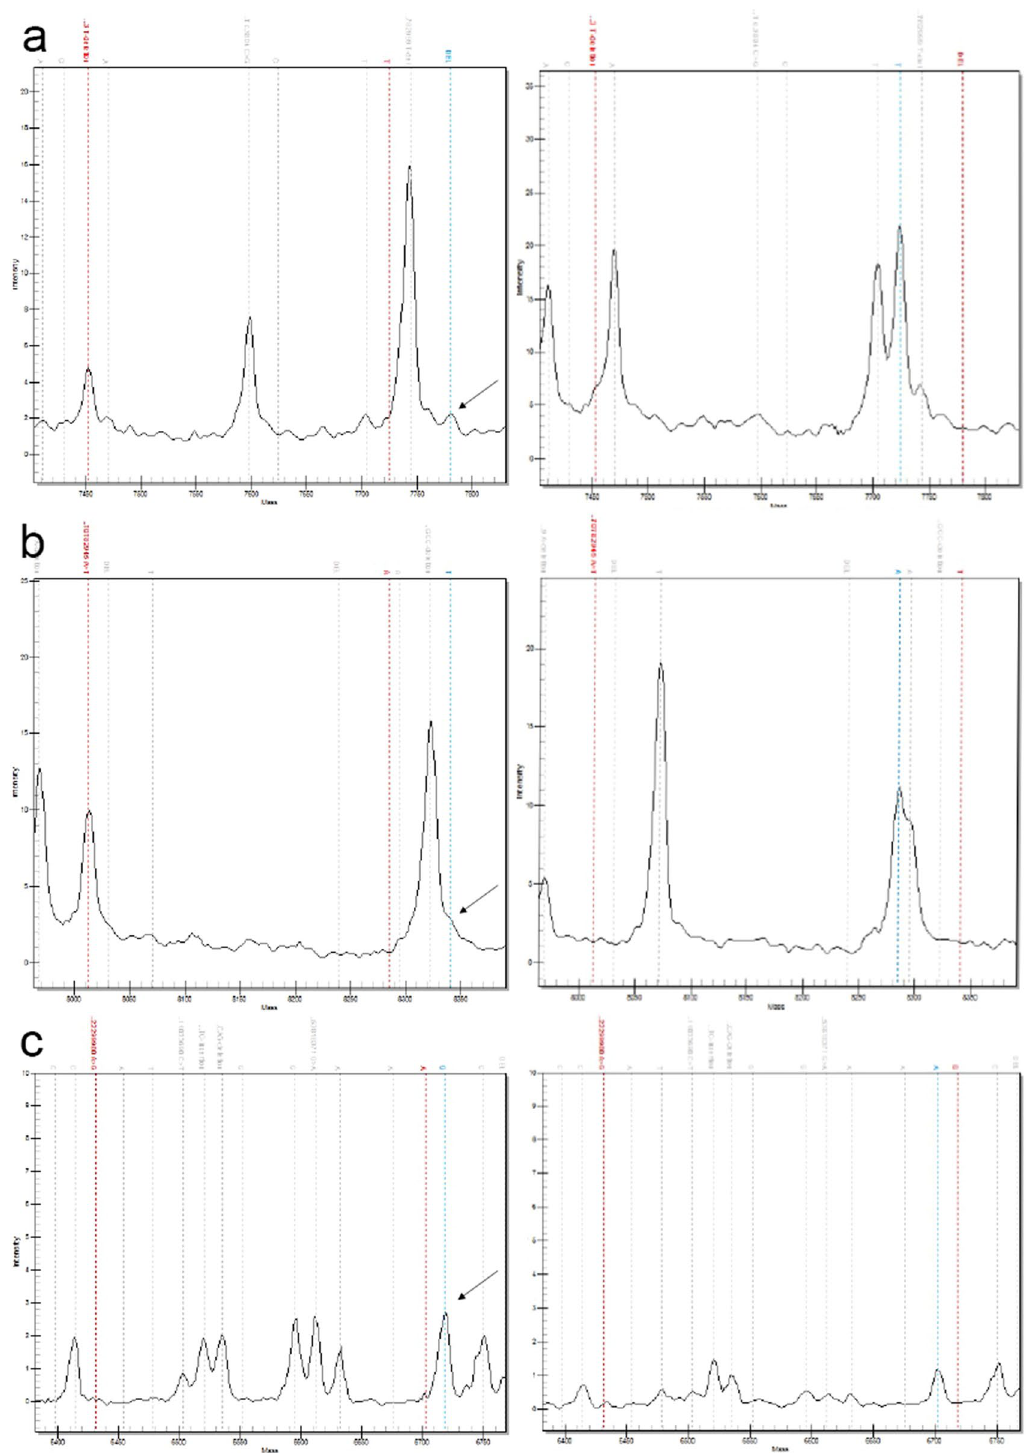
Figure 2. Example mutations depicted as mass spectra. ( a ) POT1 c.927del (p.Phe309LeufsTer3) exhibits T nucleotide deletion (arrow), ( b ) TRAF3 rs851689319 (p.Lys284Ter) presents nucleotide change from A to T (arrow), ( c ) c-KIT rs22299980 (p.Thr425 =) shows A to G substitution (arrow) compared to wild type